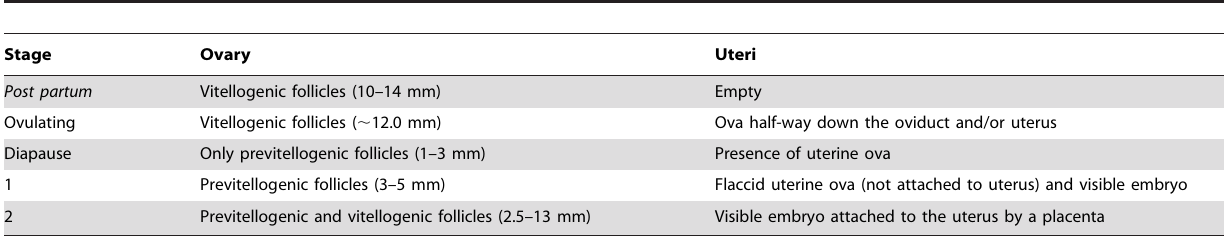
Table 1. Classification of reproductive stages for female Rhizoprionodon taylori , where the numbers within the ovary column represent the range of maximum follicular diameter during each reproductive